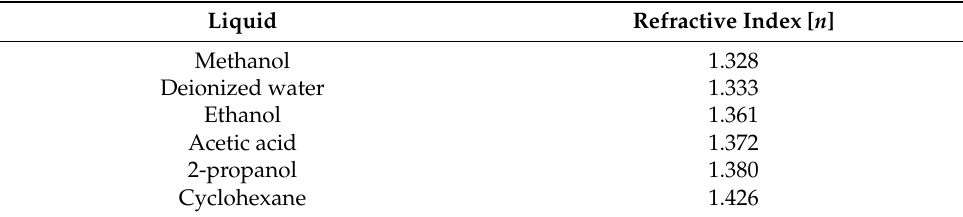
Table 1. Liquids used for the bulk sensing experiment and relative RIs at 20 ◦ C. Data from